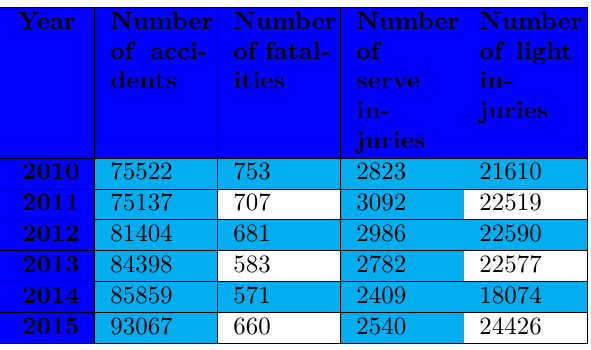
Table 1. Evolution of basic indicators of accidents in 2010-2015.